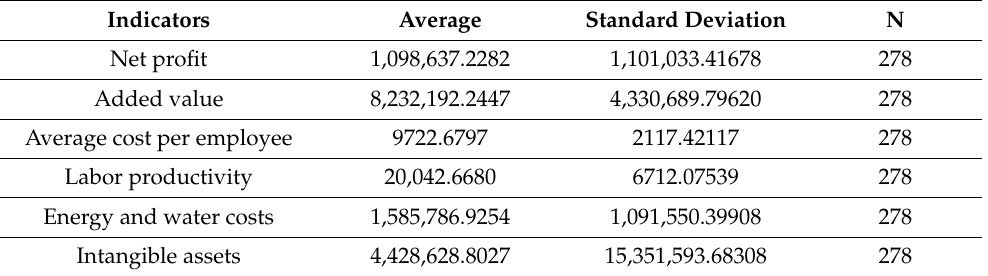
Table 2. Descriptive statistics for the sample population.